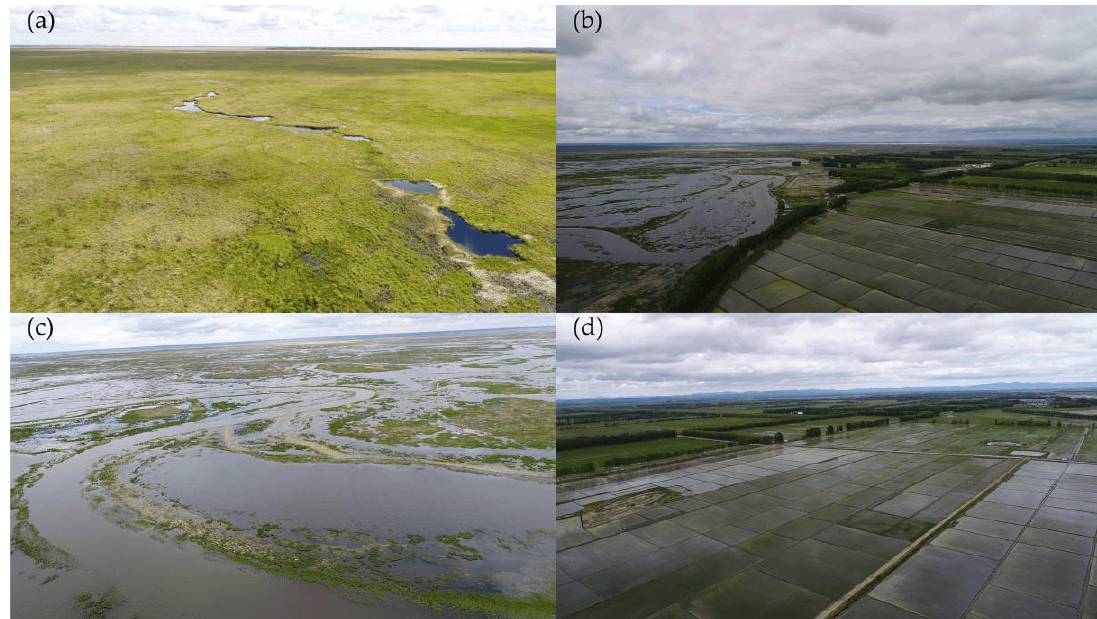
Figure 2. Different wetland types obtained by UAV: ( a ) marshland (i.e., marsh); ( b ) natural wetland and paddy field; ( c ) marshland (i.e., floodplain) and waterbody (i.e., rivers and lakes); and ( d ) paddy field.